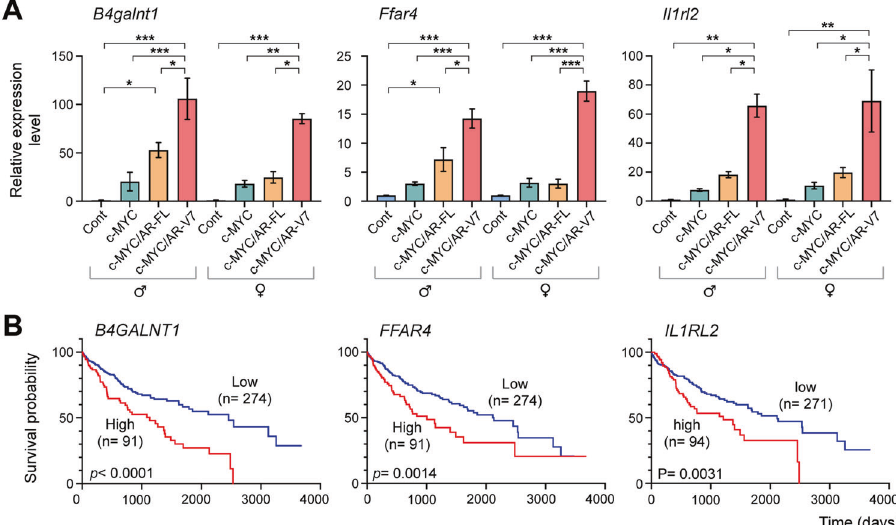
Fig. 3 Examples of three genes upregulated by AR-V7 co-expression in the c-MYC-driven mouse HCC models and the corresponding survival patterns in HCC patients. A Quantitative RT-PCR for expressions of B4galnt1, Ffar4, or Il1rl2, in respective sample groups. The Y axis indicates the expression levels relative to Gapdh. Statistical signi fi cance by one-way ANOVA with Tukey ’ s multiple comparisons test; * p < 0.05; ** p < 0.001; *** p < 0.0001. Error bars indicate mean ± SEM. B Kaplan – Meier survival plots of HCC patients in TCGA datasets for the indicated genes. Red line indicates high expressor and blue line indicates low expressor, respectively. Log-rank test P value is indicated. survival ratio in HCC patients (Fig. 3B, far left panel). Several other types including oral squamous cell carcinoma and lung adeno- genes, including the free fatty acid receptor 4 (Ffar4), and carcinoma [32, 33]. Quantitative RT-PCR analysis showed that it interleukin 1 receptor like 2 (Il1rl2), also showed similar expression patterns in our mouse model and their high levels of expression correlated with poor clinical outcomes in HCC patients (Fig. 3A, B). panel). Its expression level was negatively correlated with the